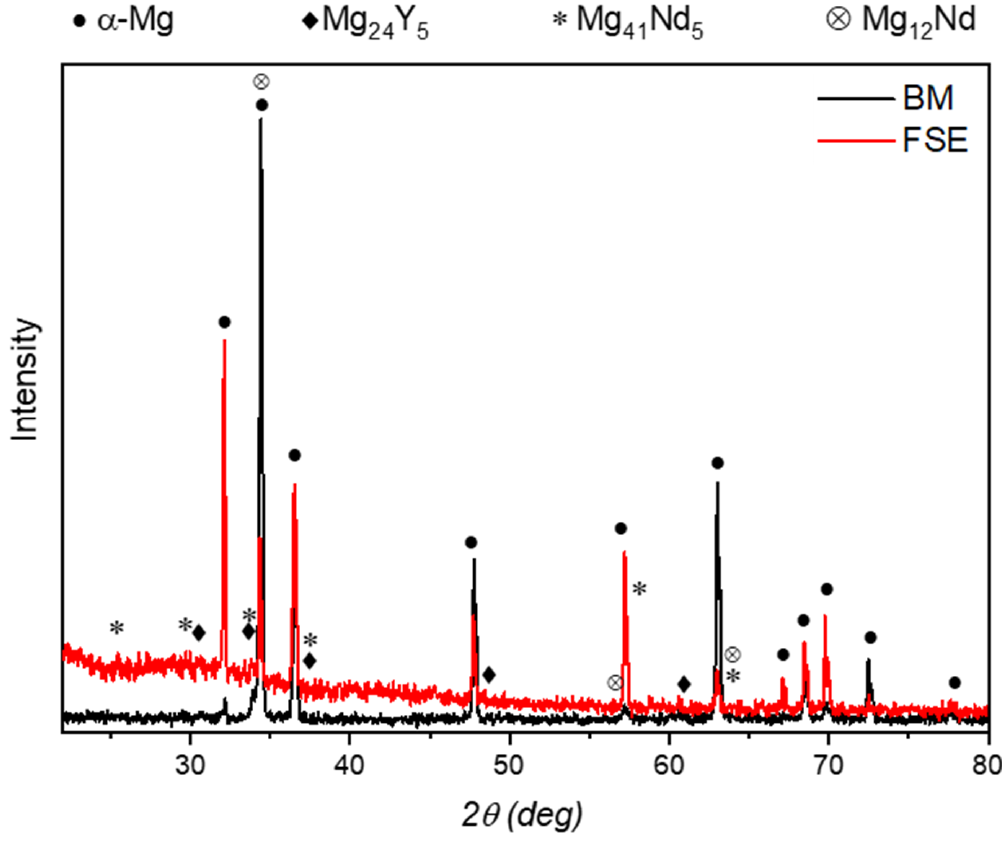
Figure 8. X-ray diffraction pattern for the base material and friction stir-extruded rod.